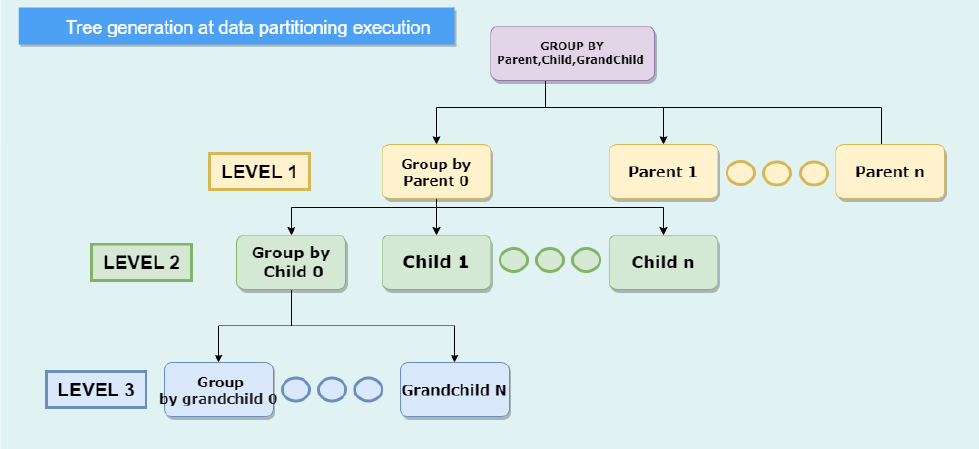
Figure 2. Example of tree